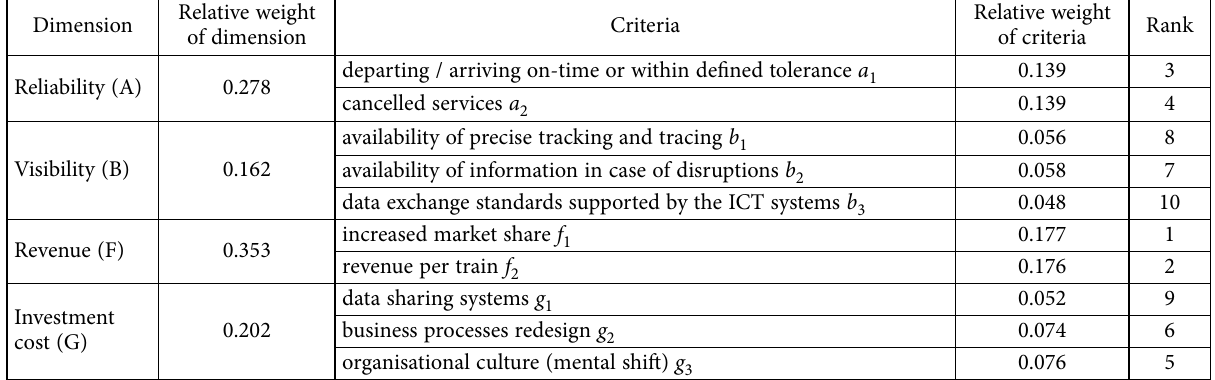
Figure 14. Causal diagram of total relationships: infrastructure manager’ perspective Table 9. Influential weights of DEMATEL–ANP for each criterion obtained by